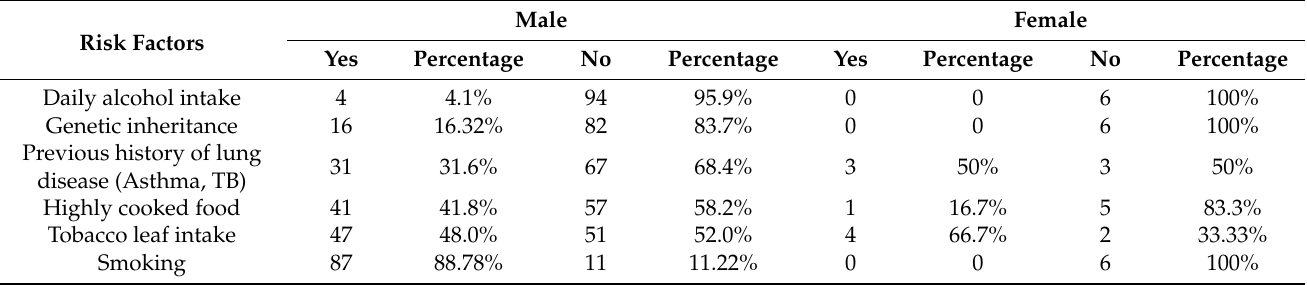
Table 1. Major causes of lung cancer among Bangladeshi population including percentage ratio based on cause and indicating chance of lung cancer in female